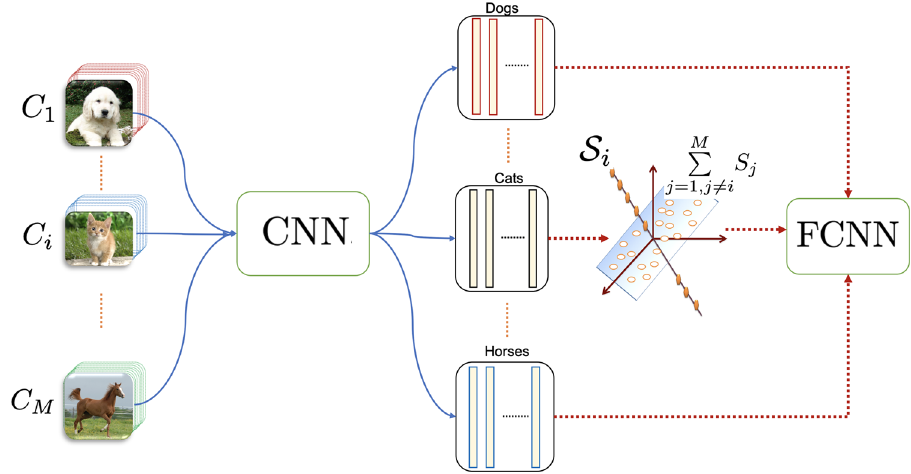
Fig. 2 System architecture for second